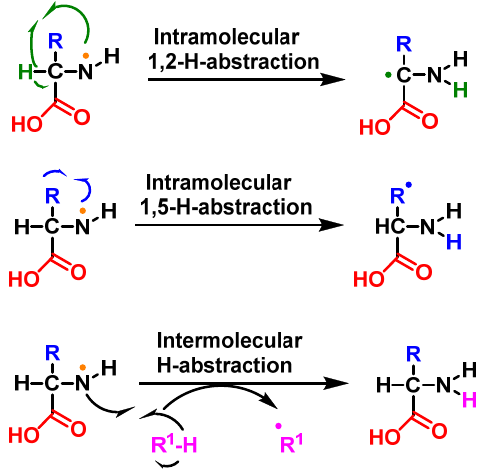
Figure 42. Intra- or intermolecular hydrogen abstraction reactions.